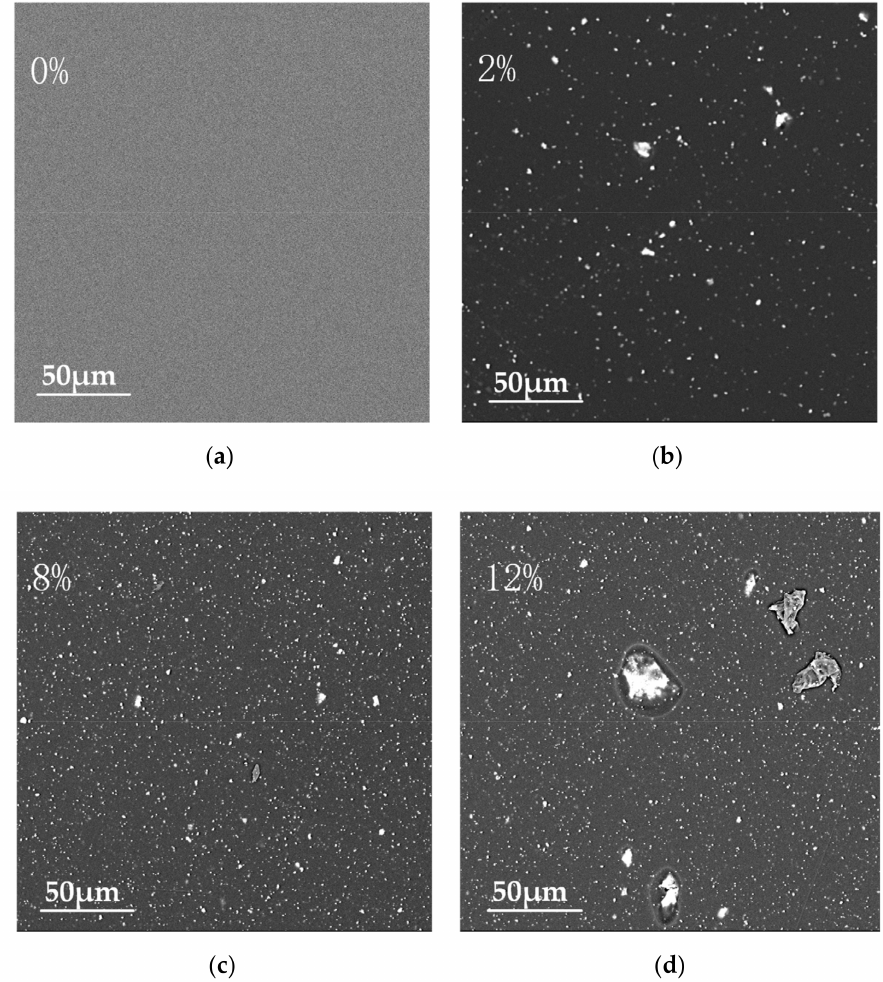
Figure 4. SEM images of nanocomposite film. ( a – d ) The planar SEM images of CCTO/PI nanocom- posite films with different doping mass